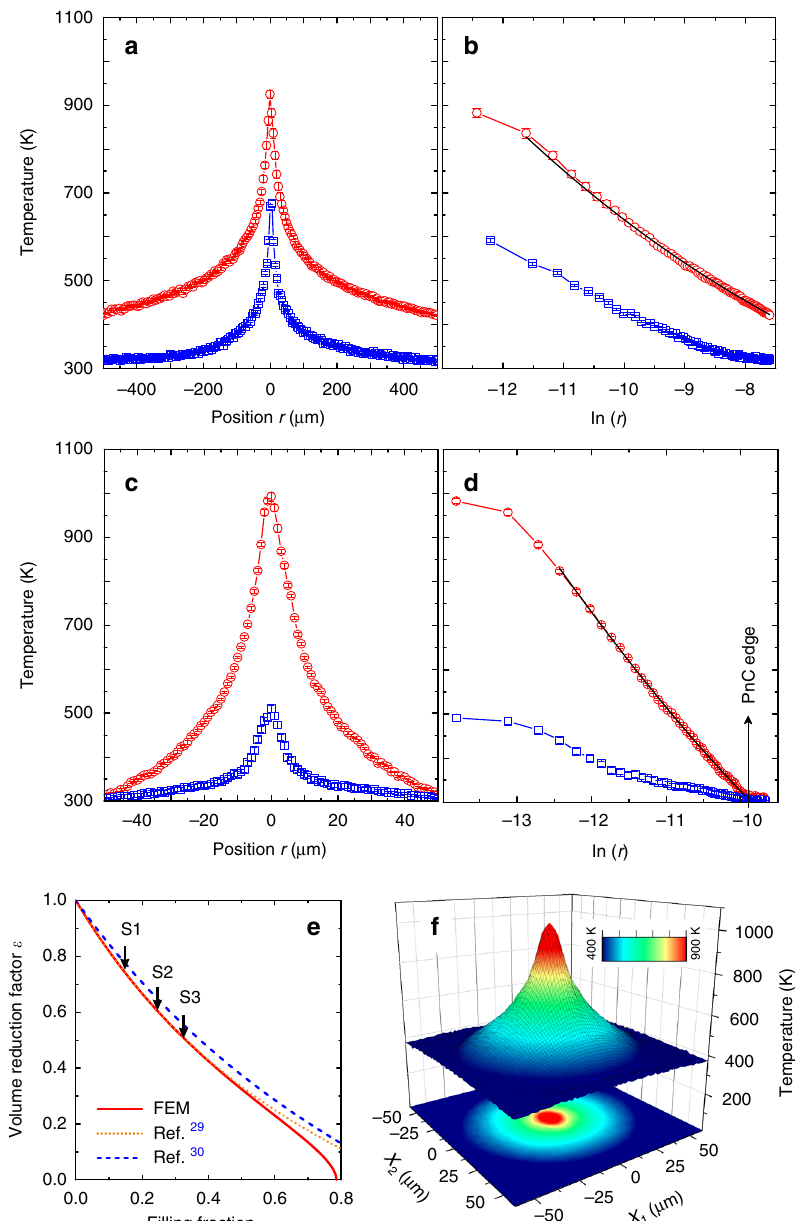
Fig. 2 Two-laser Raman thermometry results. Linear and corresponding logarithmic temperature pro fi les of a , b pristine 250 nm thick silicon membrane and c , d sample S3 with lattice parameter of a = 200 nm and hole diameter of d = 130 nm. Red circle-line and blue square-line plots indicate experimental data obtained in vacuum and air, respectively. Solid lines in b , d denote theoretical fi ts using Eq. (2). Error bars in a , b , c , d represent experimental uncertainties of the measured temperature (see Methods Section). e Volume reduction factor ε as a function of porosity calculated by FEM and using analytical expressions. f Measured temperature map of the sample S1 with lattice parameter a = 300 nm and hole diameter d = 135